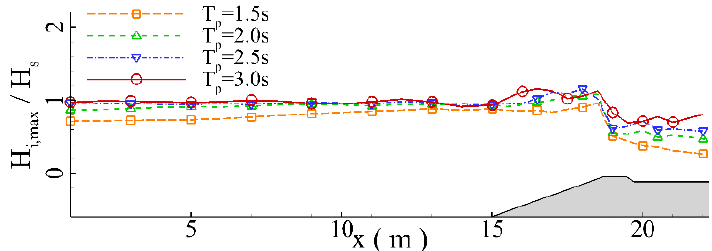
Figure 27. Maximum water elevation at the reef crest versus the peak wave period.